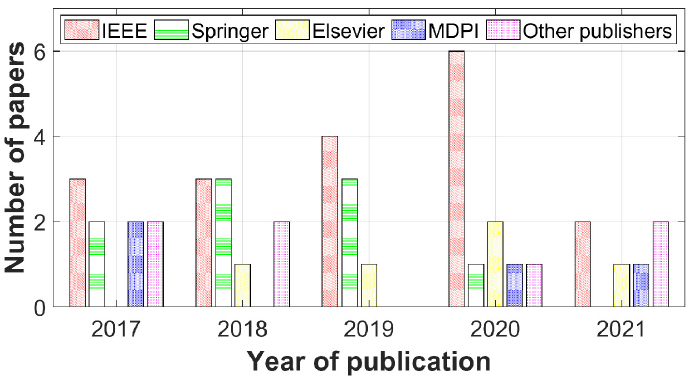
Figure 1. Distribution of research